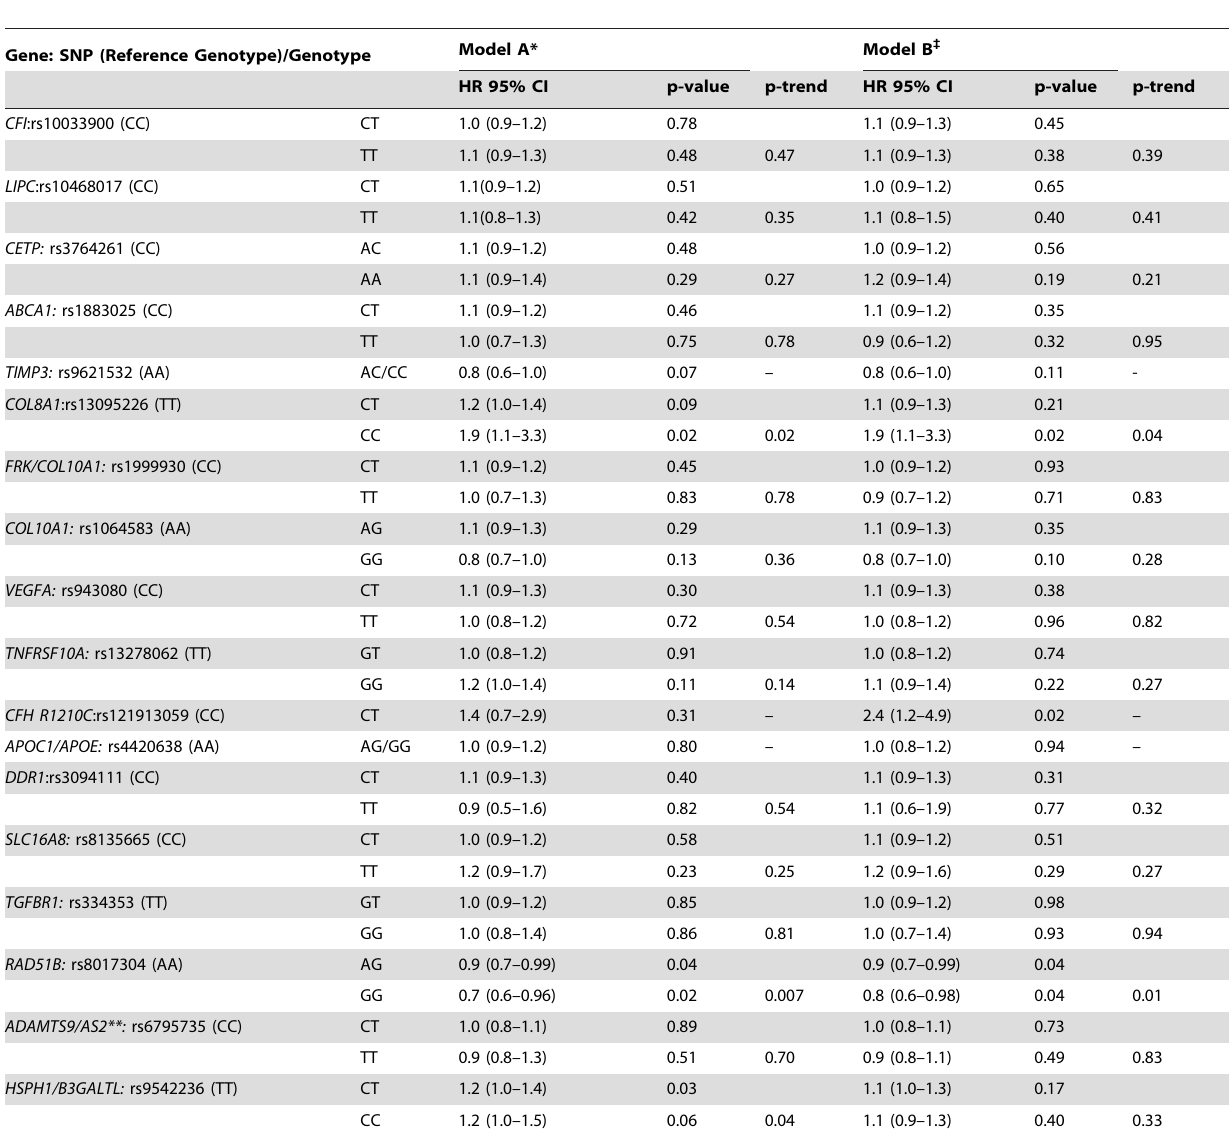
Table 3. Associations between New Age-Related Macular Degeneration Genetic Loci and Incidence of Advanced Age-Related Macular Degeneration, Controlling for Demographic, Environmental, Ocular and Genetic Factors.